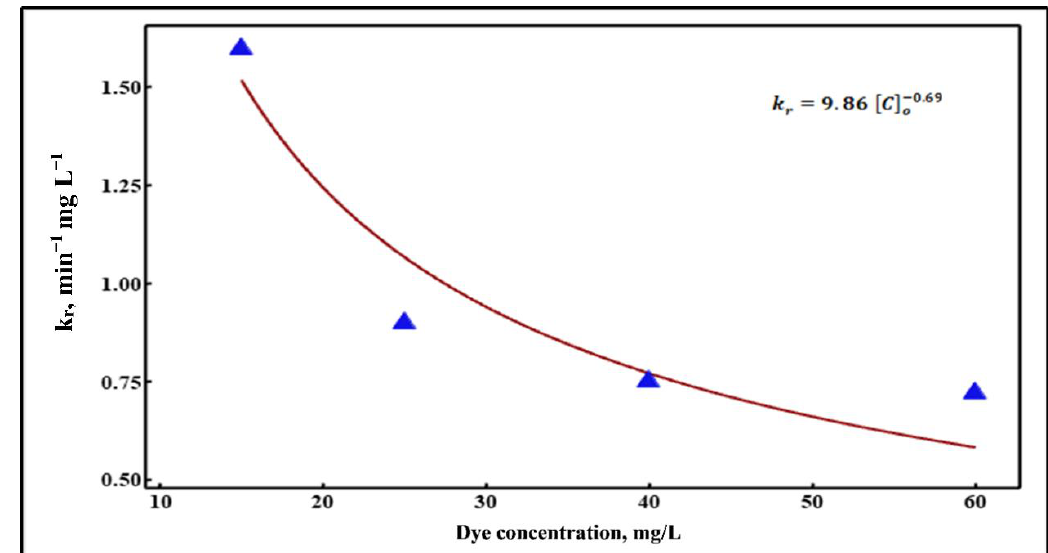
Figure 8. Non-linear regression of k r values vs. different dye concentrations.